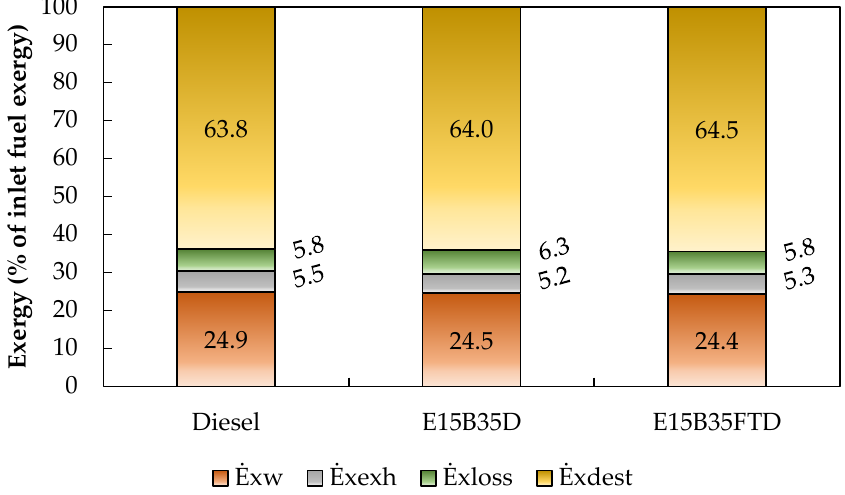
Figure 7. Exergy balance of the engine for each tested fuel.